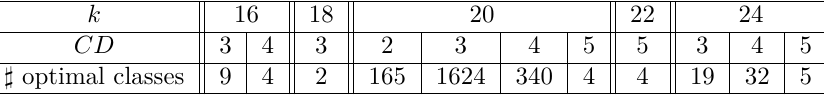
Table 6: Collision-free depths of optimal even-odd